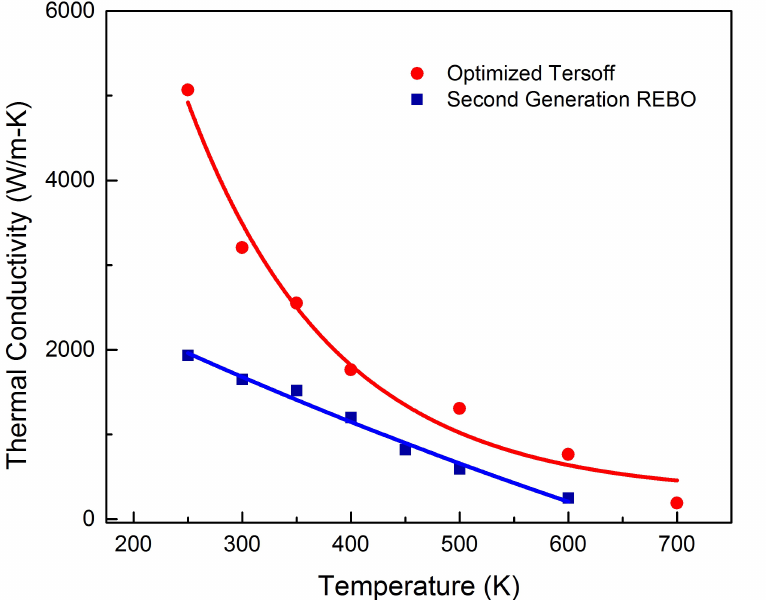
Figure 4. Thermal Conductivity (uncorrected) of GNR (10 nm × 1 nm) as a function of temperature using two different interatomic